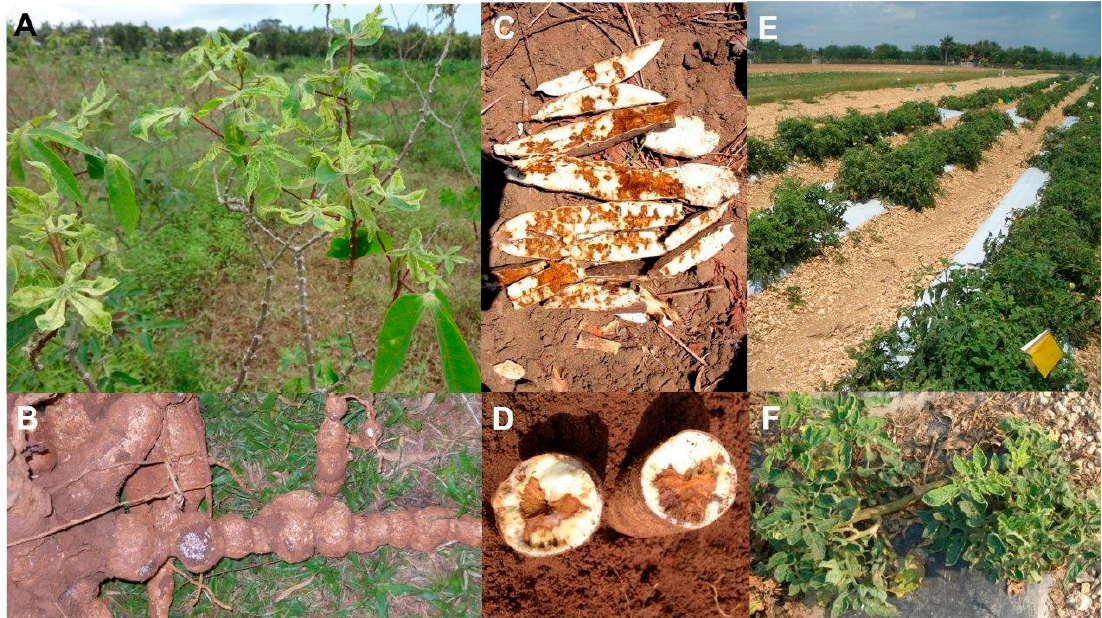
Figure 1. ( A ) Field of cassava devastated by cassava mosaic disease. Remaining upper leaves on diseased, mostly defoliated plants show symptoms consisting of severe mosaic and leaf deformation, image modified from [7]. ( B ) Roots of cassava showing marked constrictions caused by cassava brown streak disease (CBSD) (image credit @Natural Resource Institute/Maruthi Gowda). ( C ) Tuberous roots of cassava cut along their lengths showing dry necrotic rotting caused by CBSD (image credit @Natural Resource Institute/Maruthi Gowda). ( D ) Tuberous roots of cassava cut in cross section of showing dry necrotic rotting caused by CBSD (image credit @Natural Resource Institute/Maruthi Gowda). ( E ) Field of tomato devastated by tomato yellow leaf curl disease (TYLCD). All plants have symptoms of diminished leaf size, bunched growth, plant stunting, and lack of fruit formation, image modified from [5]. ( F ) Tomato plant showing severe symptoms of small, pale and upcurled leaves, bunched growth and plant stunting caused by TYLCD following early growth stage infection.